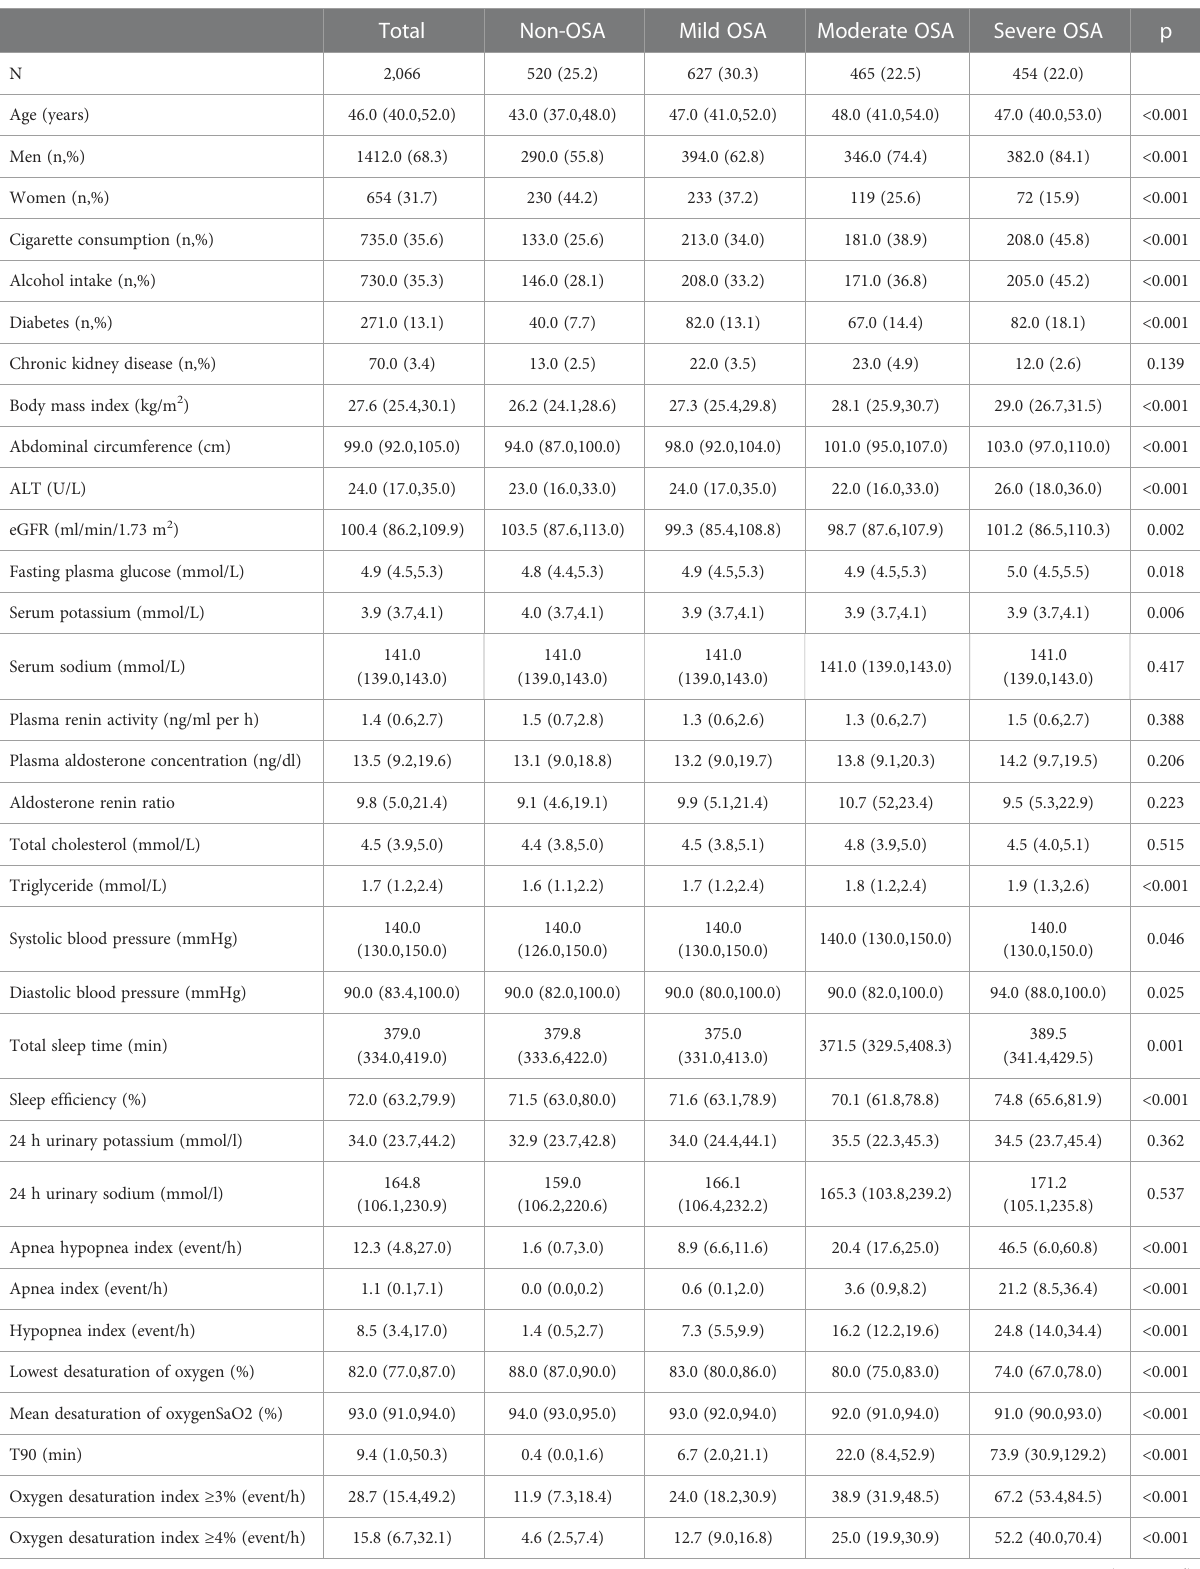
TABLE 1 Characteristics of hypertensive participants by total and by severity of obstructive sleep apnea (OSA) with measured plasma aldosterone under no interfering agents in UROSAH cohort. Total Non-OSA Mild OSA Moderate OSA Severe